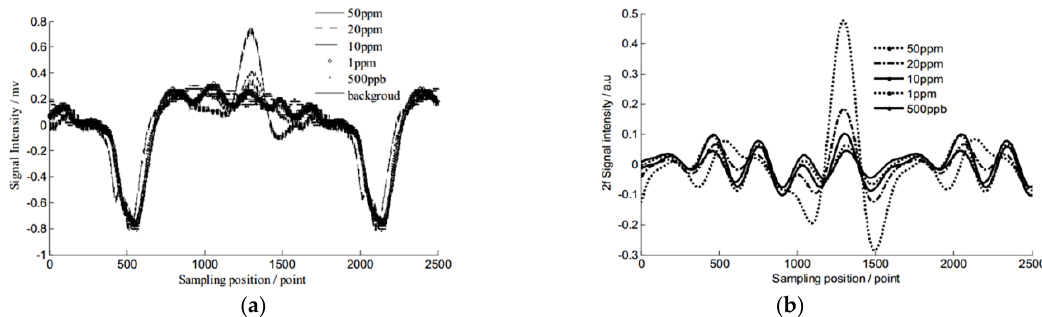
Figure 3. ( a ) signal without WD ( b ) signal with WD. This figure was obtained from reference [39].